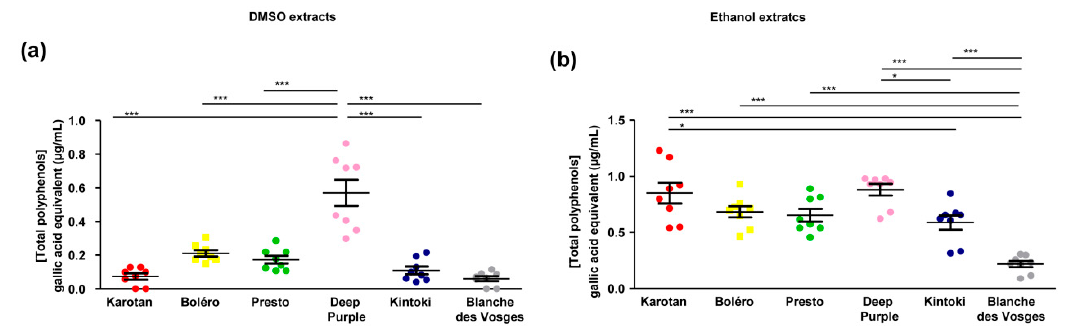
Figure 3. Total polyphenol content in carrot extracts. Diagrams represent content of total polyphenols in DMSO ( a ) and ethanol ( b ) carrot extracts from six different varieties of carrots (Bolero, Presto, Deep Purple, Karotan, Kintoki and Blanche des Vosges), independently from growing conditions and expressed as µg/mL gallic acid equivalents. Statistical analyses were performed by one-way ANOVA and Tukey post hoc test, * p < 0.05, *** p < 0.001.